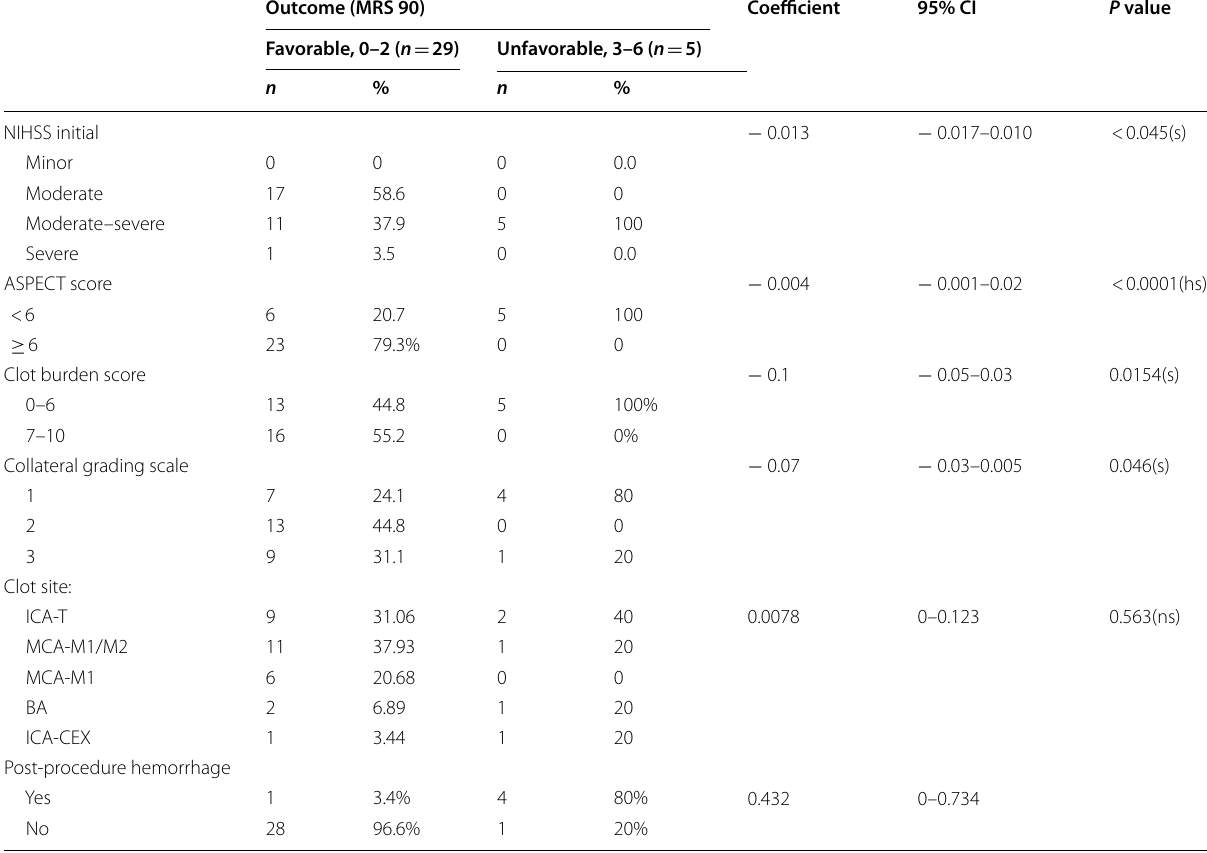
Table 3 Multiple regression table for predictors of clinical